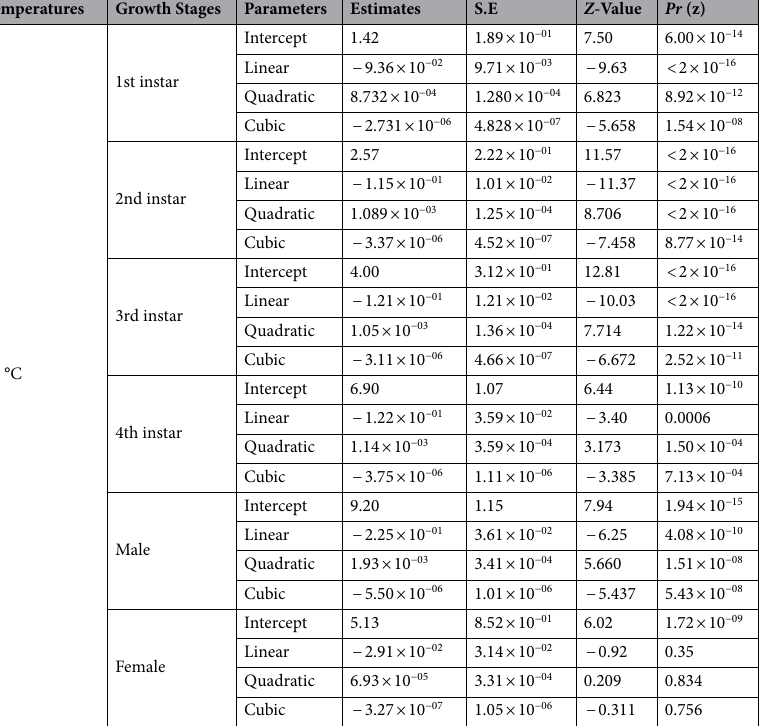
Table 1. Results of the logistic regression analysis of the proportion of nymphs of Acyrthosiphon pisum predated by all stages of Harmonia axyridis relative to the initial number of nymphs provided.